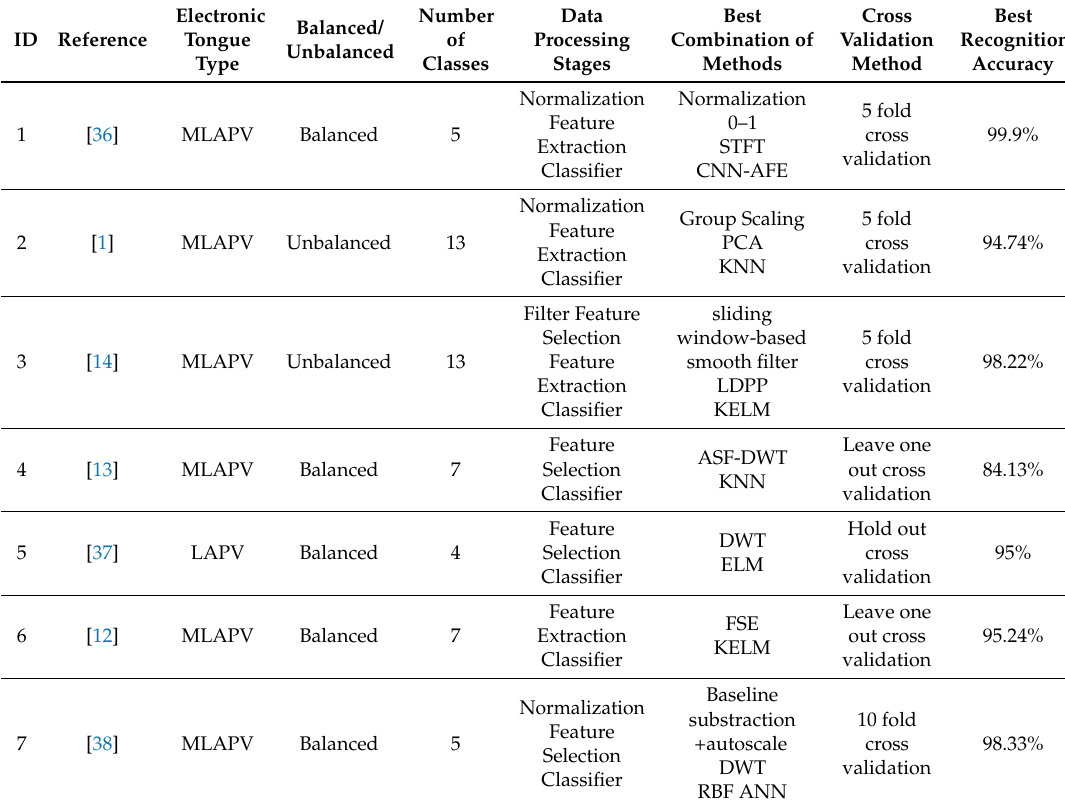
Table 1. Summary of different works related with pattern recognition methodologies in MLAPV electronic